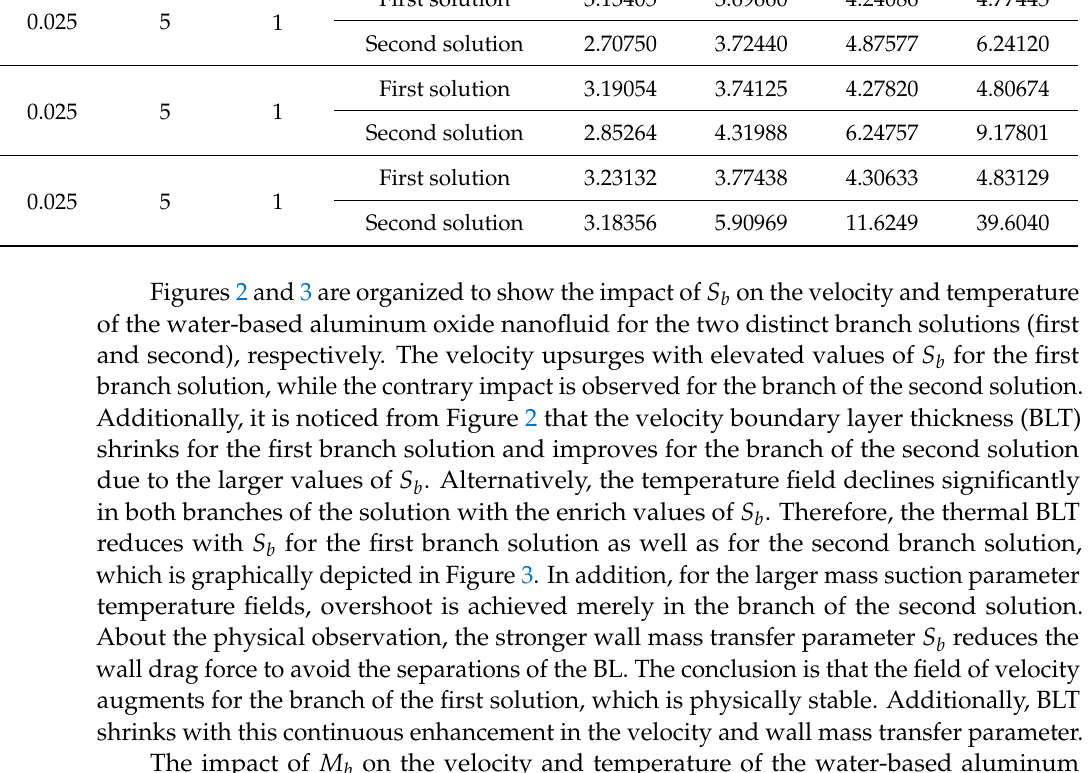
Table 4. Values of −